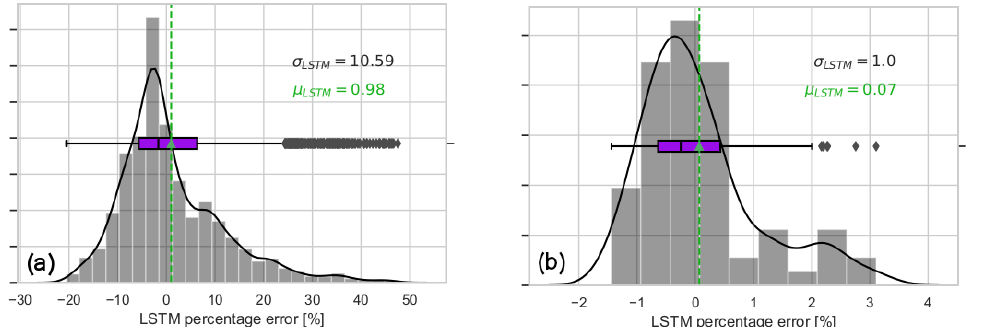
Figure 14. LSTM network prediction error for the further transfer learning flow case. Mean wind speed = 11ms − 1 and TI = 10% over the 60min validation case. (a) The 1Hz prediction error; (b) the 1min average prediction error.